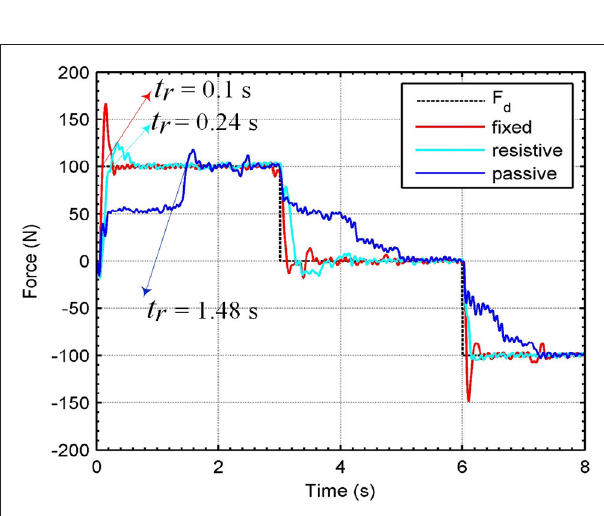
FIGURE 7 | Recursive RR-DMJLS force controller. Force response (solid), sinusoidal force reference (dashed) with a change of operation mode (top). Markov chain (bottom).